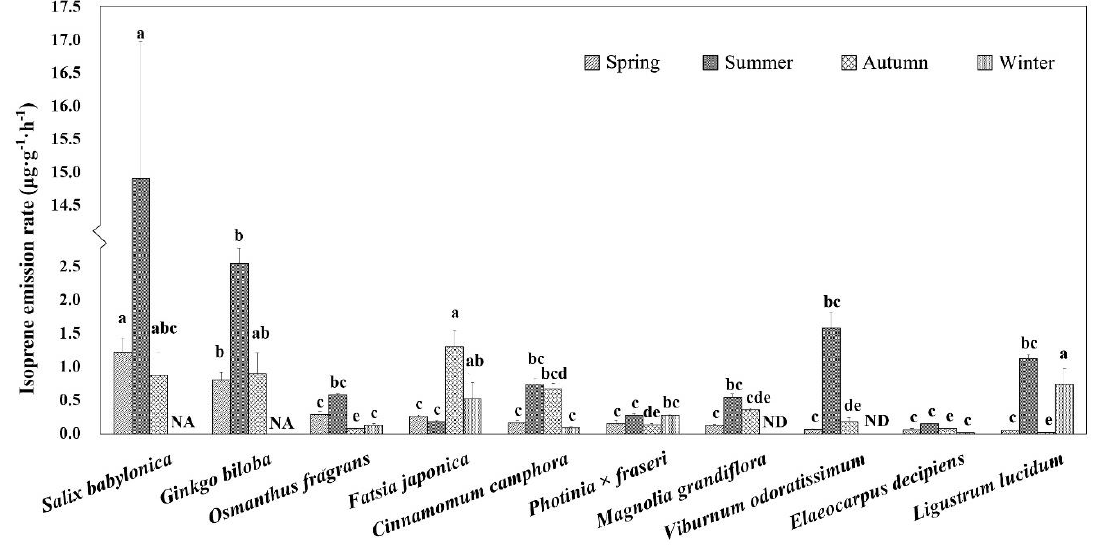
Figure 3. Isoprene emission rates of 10 typical plants in different seasons. a, b, c, d, e—within a season, species not sharing a common letter differ significantly (α = 0.01) in emission rate. ND = not detectable. NA = not available ( Salix babylonica and Ginkgo biloba defoliated in autumn and winter).